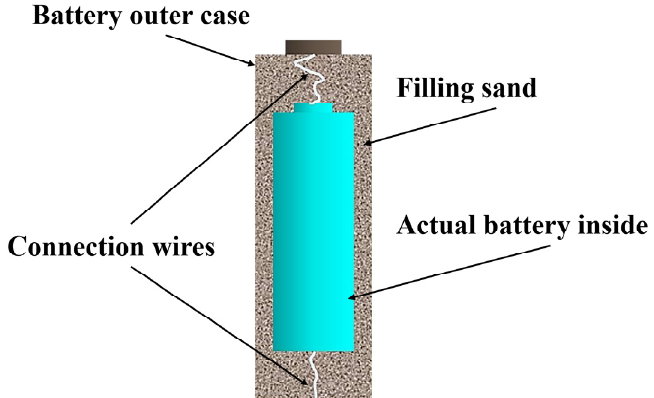
Figure 2. Schematic illustration for a counterfeit 18650 battery, made from a shorter 18350 battery.